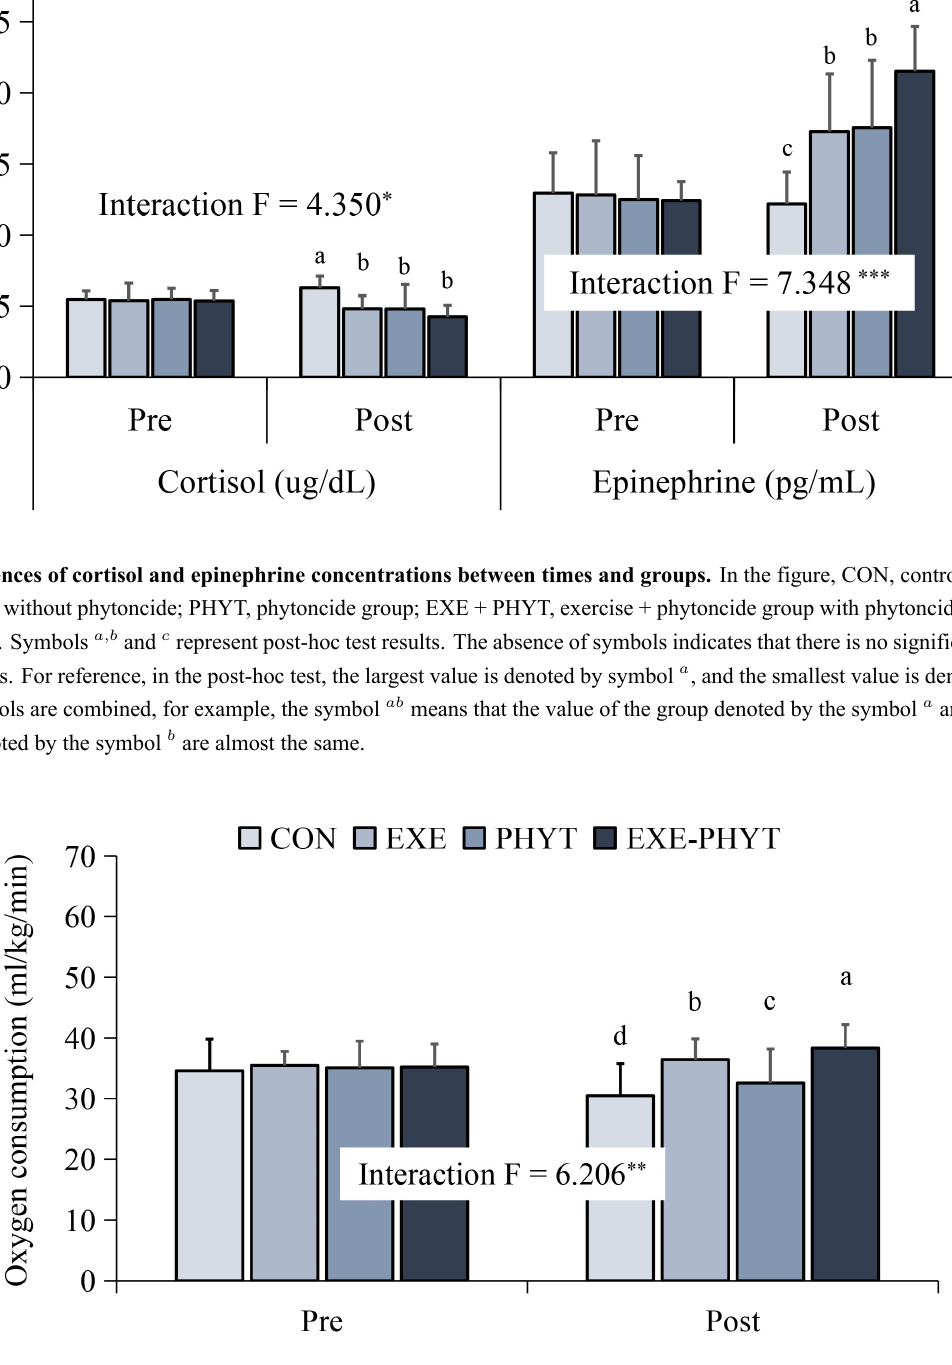
Fig. 5. Differences of physical fitness between times and groups. In the figure, CON, control group; EXE, exercise group without phytoncide; PHYT, phytoncide group; EXE + PHYT, exercise + phytoncide group with phytoncide; ∗∗ , p < 0.01; ∗∗∗ , p < 0.001. Symbols a,b,c and d represent post-hoc test results. The absence of symbols indicates that there is no significant difference between groups. For reference, in the post-hoc test, the largest value is denoted by symbol a , and the smallest value is denoted by b , c or d . When symbols are combined, for example, the symbol ab means that the value of the group denoted by the symbol a and the value of the group denoted by the symbol b are almost the